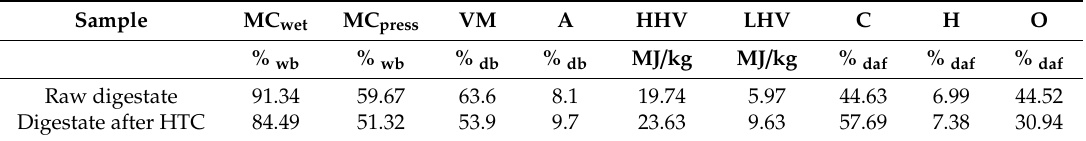
Table 1. Results of the proximate and ultimate analysis of raw and hydrothermally treated hydrochar (moisture content (MC); wet material (wet); material after pressing (press); volatile matter content (VM); ash content (A); higher heating value (HHV); lower heating value (LHV); carbon content (C); hydrogen content (H); oxygen content (O); wet basis (wb); dry basis (db); and dry ash-free basis